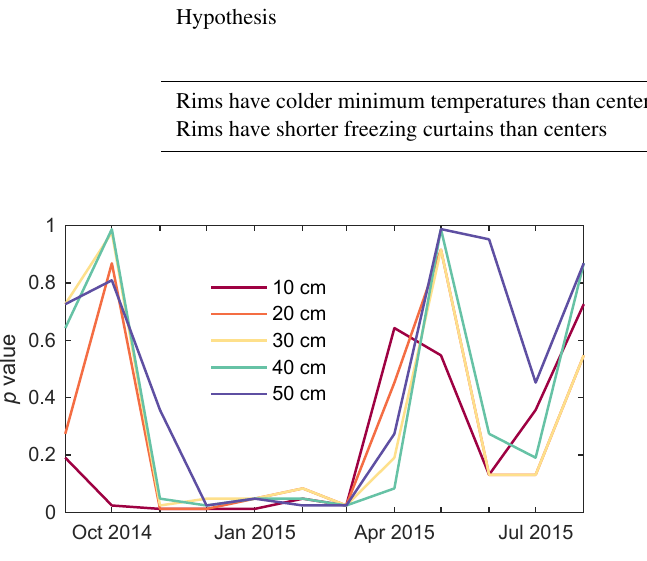
Figure 5. Results of the rank sum test, evaluating whether mean monthly temperatures are colder in the rims than in the centers.